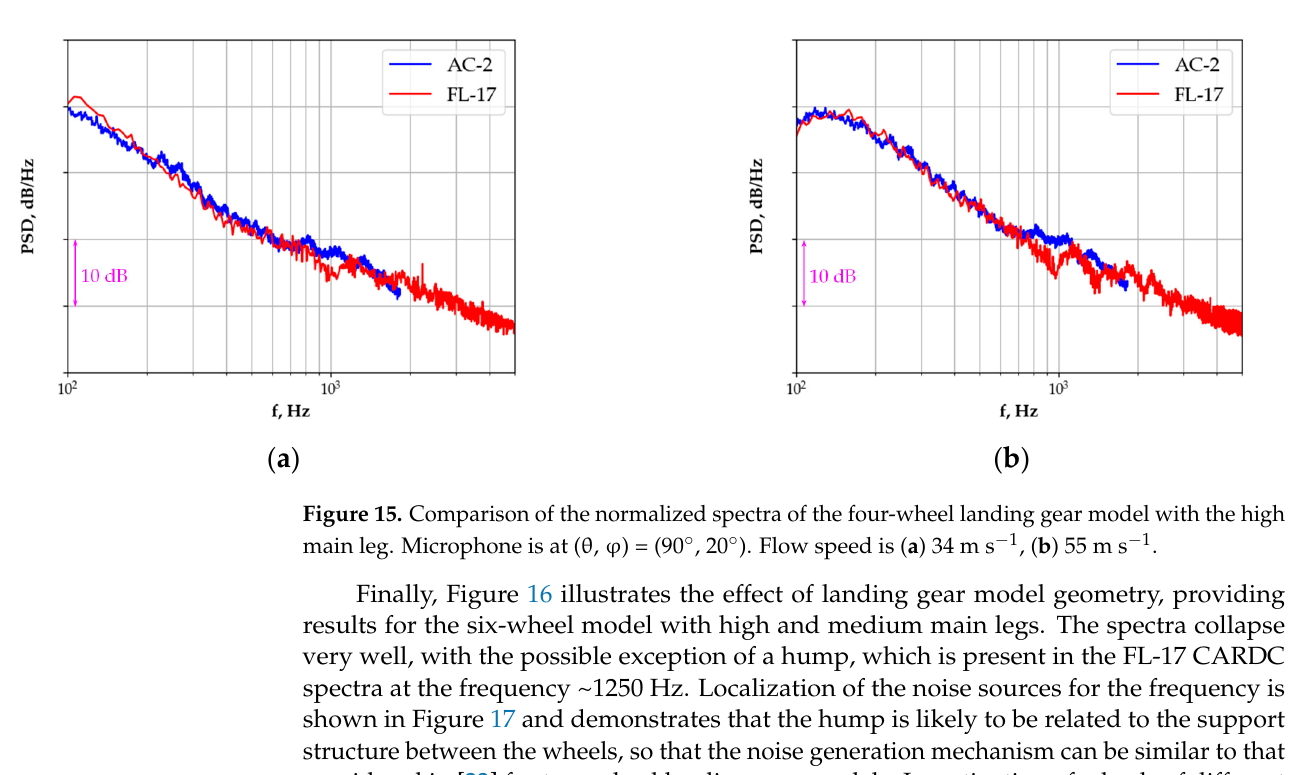
Figure 14. Comparison of the normalized spectra of the four-wheel landing gear model with the high main leg. Flow speed is 75 m s − 1 . Microphone is at ( a ) ( θ , φ ) = (70°, 20°), ( b ) ( θ , φ ) = (110°, 20°).